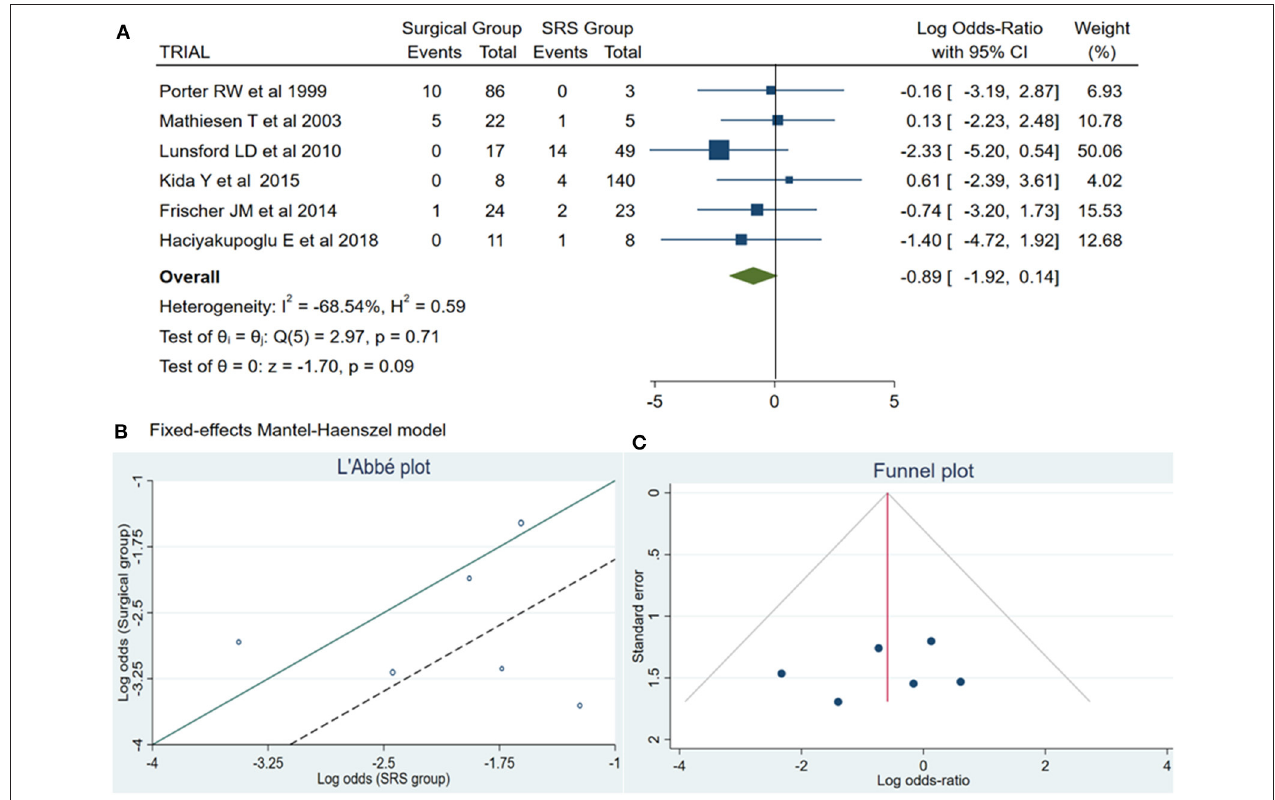
FIGURE 2 | (A) Forest plot permanent neurologic deficit (PND): Results demonstrate no statistically significant difference between the two groups [decimal logarithm of odd ratio – log OR − 0.89, CI 95%, 0.14 to − 1.92, and p = 0.09]. (B) L’Abbé plot and contribution to overall heterogeneity ( p = 0.71 and I 2 = − 68.54%). (C) Funnel plot, testing the sensitivity with funnel plot for PND, no statistically significant superiority existed between both groups, with low publication bias. SRS, Radiosurgical group; PND, permanent neurologic deficit; I 2 shows the percentage of total variation across studies that is due to heterogeneity rather than chance; CI, confidence